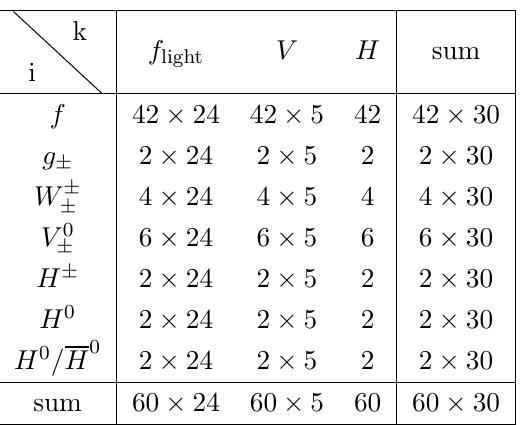
Table 1 . Total number of fragmentation functions required. For a given (cid:12)nal-state particle k , one requires a total of 60 FFs, which is the same as the number of PDFs needed for the initial state. Each object i can fragment into 30 particles k (the total number of particles and antiparticles